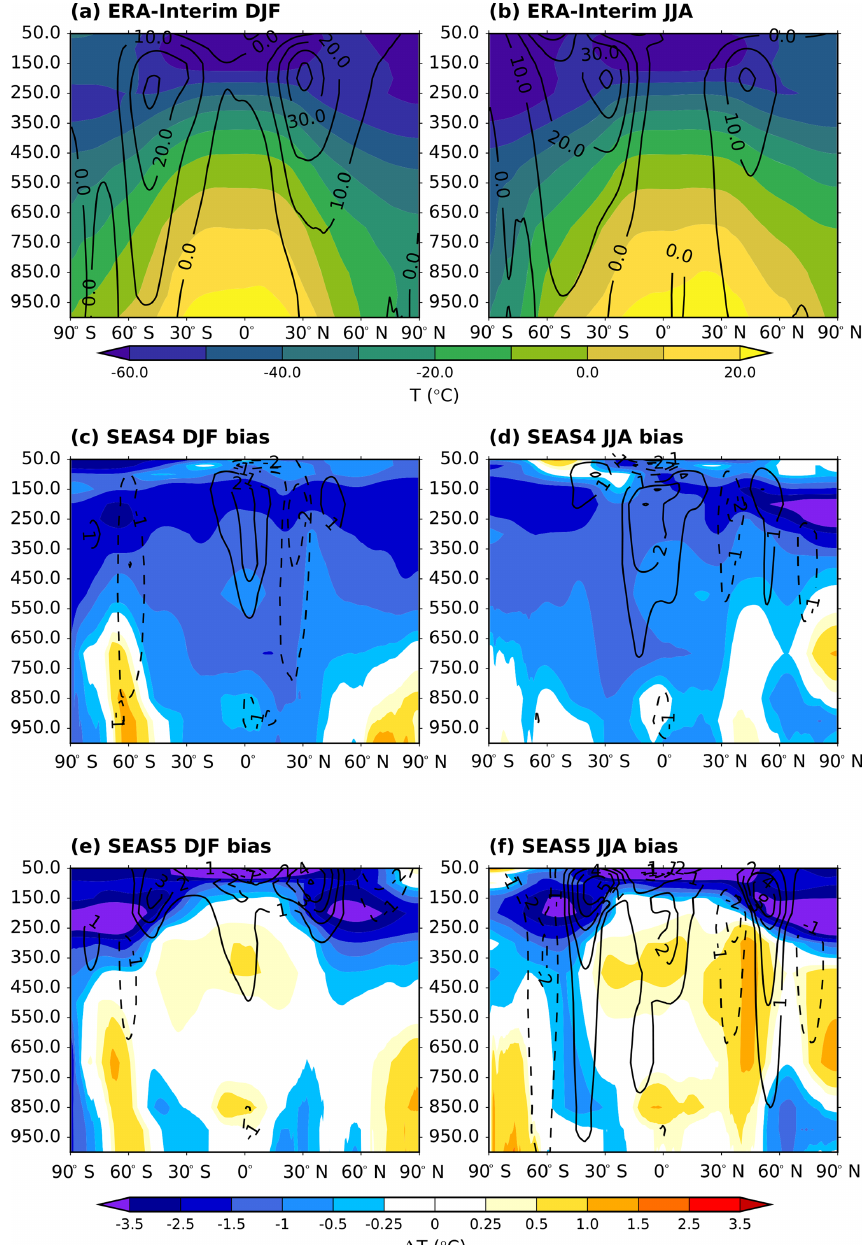
Figure 8. ERA-Interim zonally averaged profiles of temperature (colours) and zonal wind (contours) for DJF (a) and JJA (b) , as well as the biases of SEAS4 (c, d) and SEAS5 (e, f) at 1 month forecast